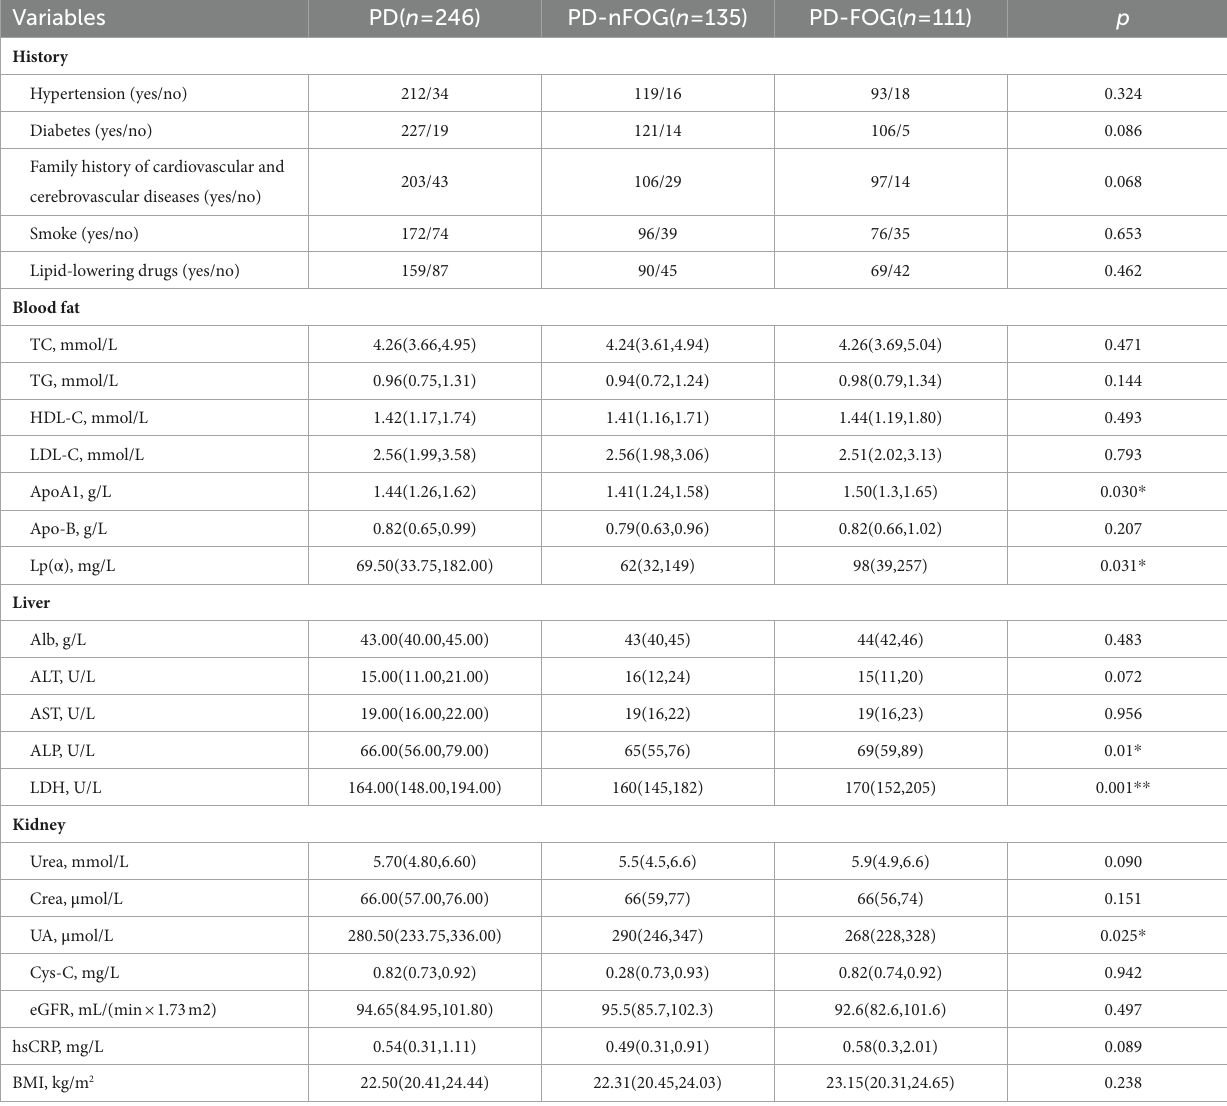
TABLE 2 Comparison of cerebrovascular risk factors of the two participants